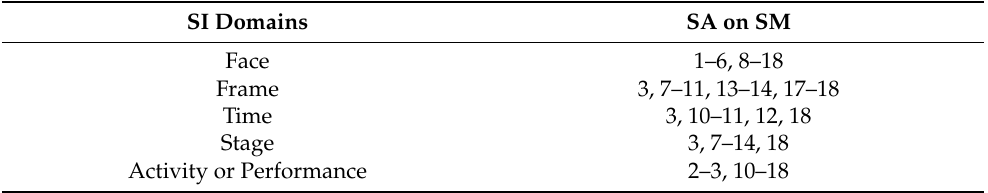
Table 2. Social Identity Domains and Social Attributes on Social